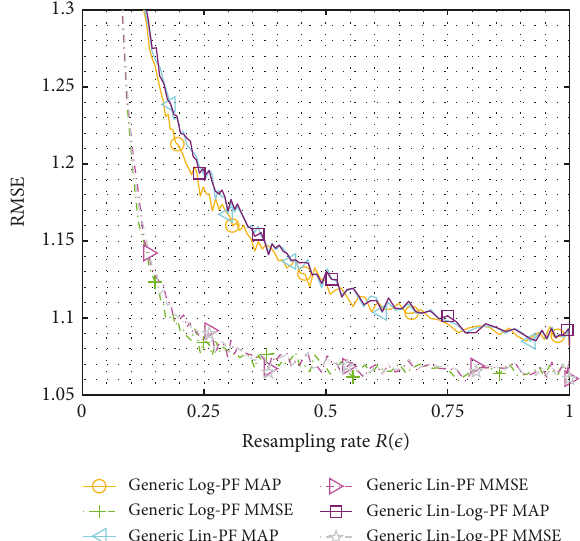
Figure 4: Performance evaluation of the Generic Log-PF, Generic Lin-PF, and Generic Lin-Log-PF by the RMSE versus the resampling rate 𝑅(𝜖) .